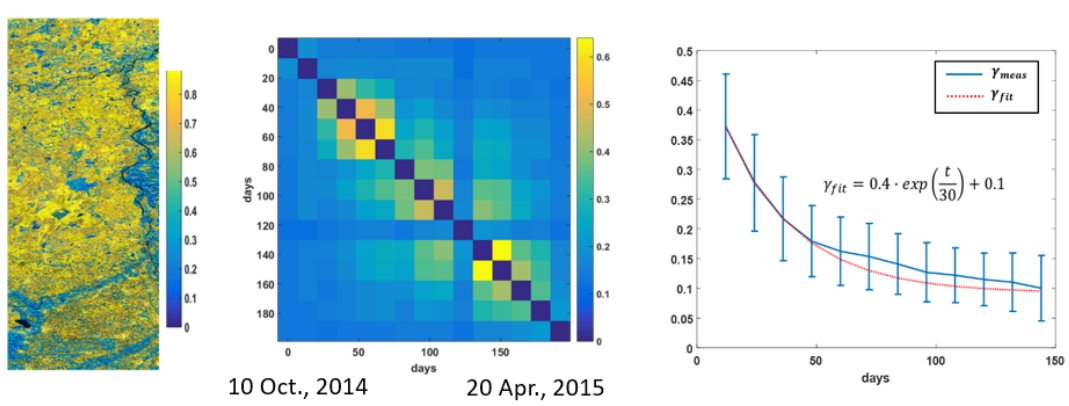
Figure 10. Long-term coherence of agricultural fields observed in C band, by Sentine1-1 SAR, every 12 days for about five months. ( Left ): an example of a 12-days revisit coherence. ( Mid ): matrix with the median of the coherences measured for each pair. ( Right ): fitting of the temporal decorrelation by the gRW model in (18).